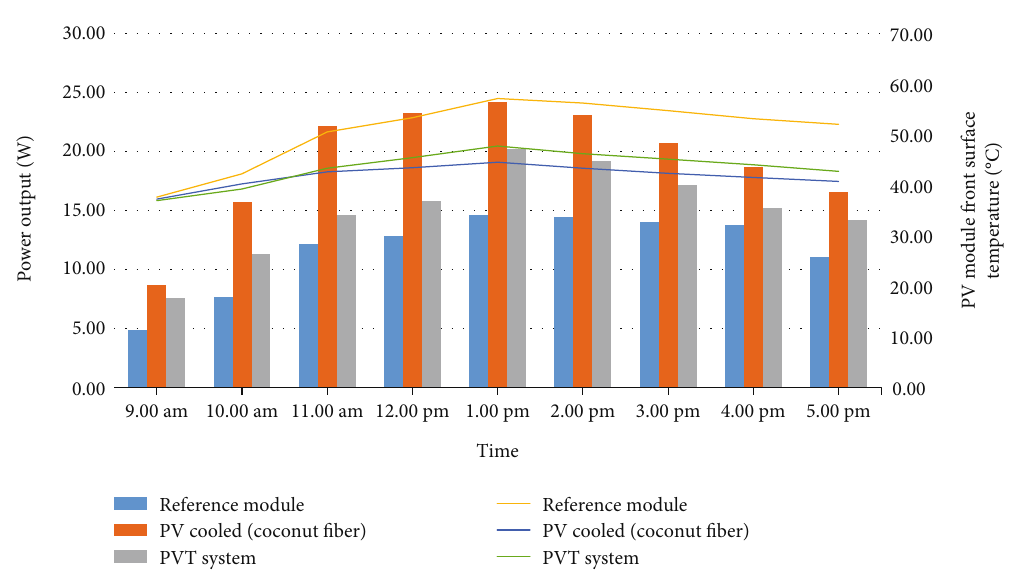
Figure 6: Comparison of power outputs and module temperature of uncooled, cooled, and PVT modules.